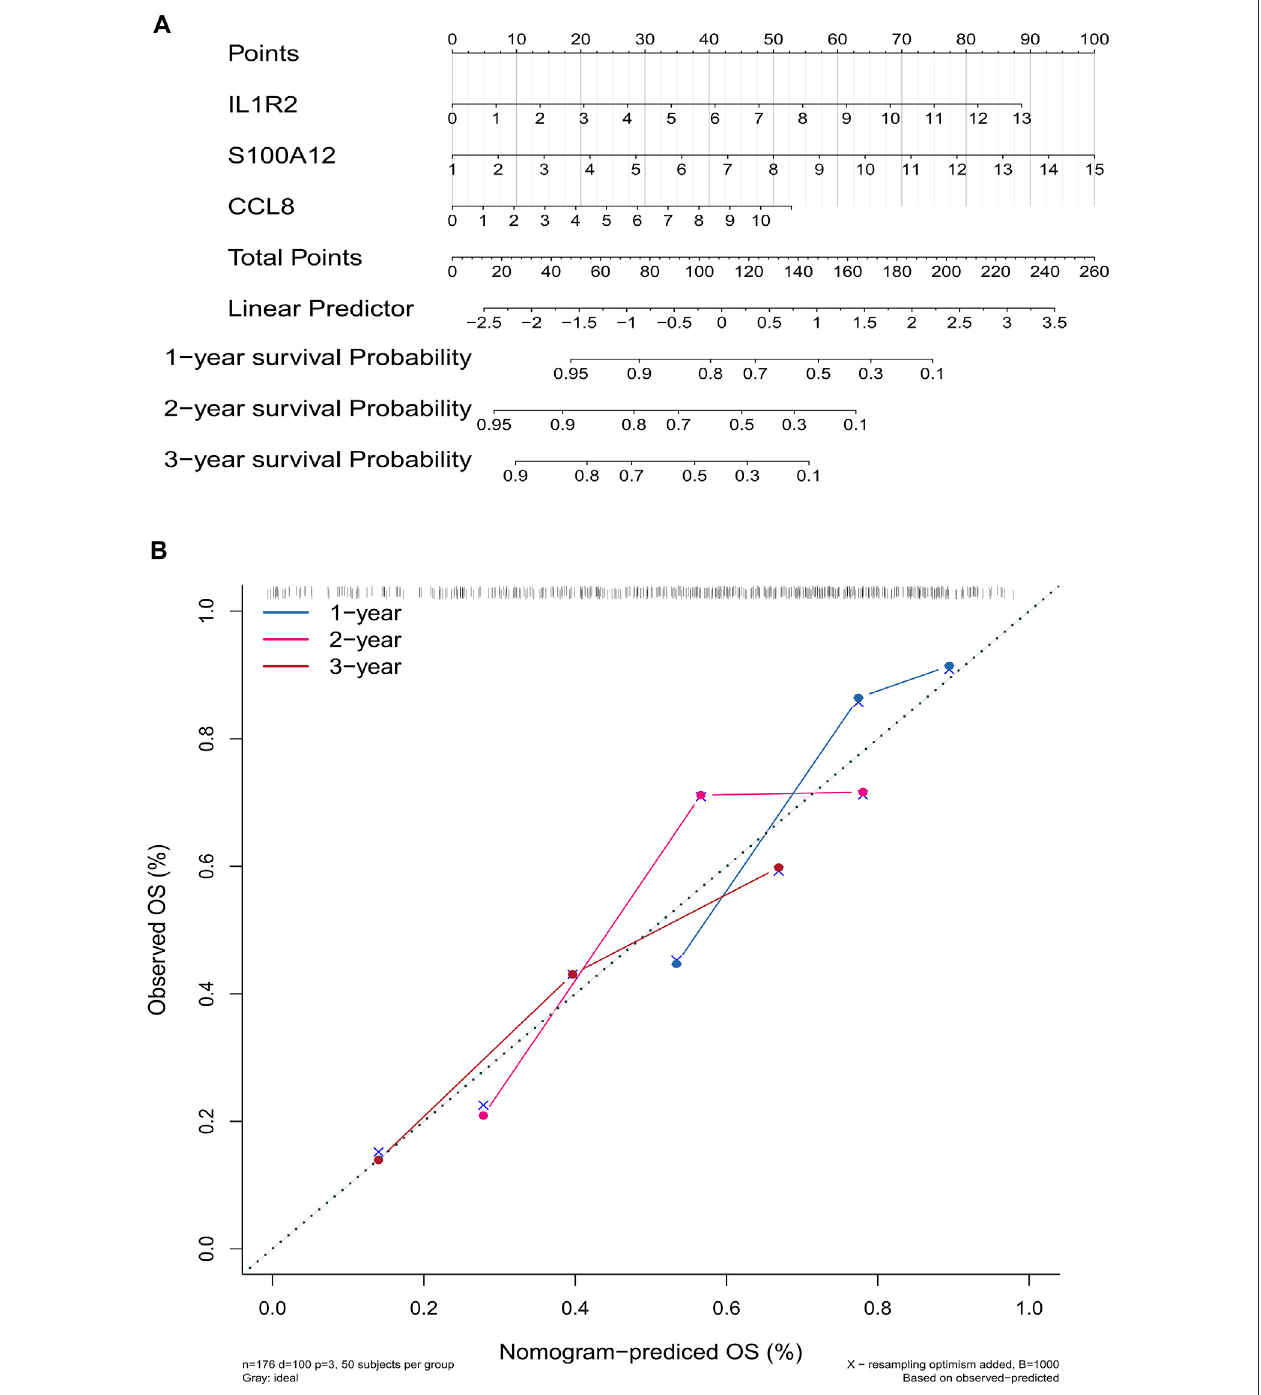
FIGURE 6 | Construction and evaluation of a nomogram for predicting 1-, 2-, and 3-year survival rates of IPF patients in the training set. (A) Nomogram for predicting 1-, 2-, and 3-year survival of IPF patients. (B) Calibration curves showing the probability of 1-, 2-, and 3-year survival between the prediction and the